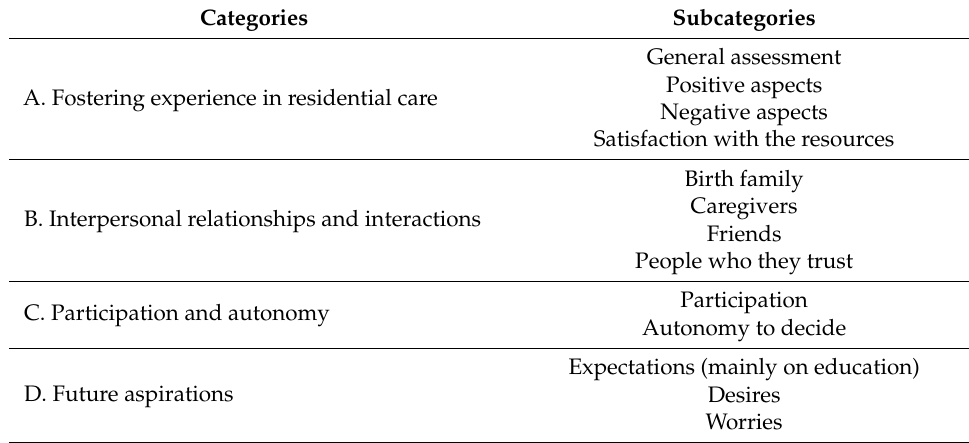
Table 2. Categories and